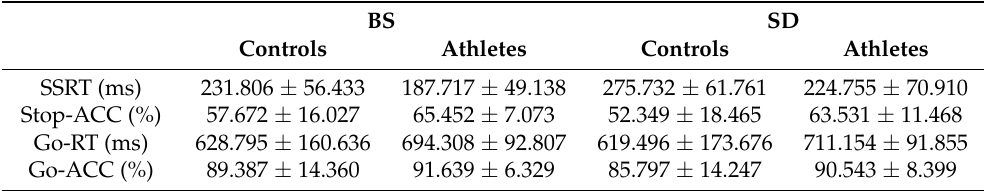
Figure 3. Response time and accuracy of behavioral indicators (mean ± SD). The blue bars represent the baseline state (BS), and the red bars represent the sleep deprivation (SD). ( A ) SSRT: Stop signal response time. ( B ) Stop Accuracy: % correct inhibited responses in stop trials. ( C ) Go RT: Time till correct response in the go trials. ( D ) Go Accuracy: % correct responses in go trials. * = p < 0.05, ** = p < 0.01. Table 2. Means and standard deviations of the behavioral data listed for all conditions (BS_Controls, BS_Table tennis athletes, SD_Controls, SD_Table tennis